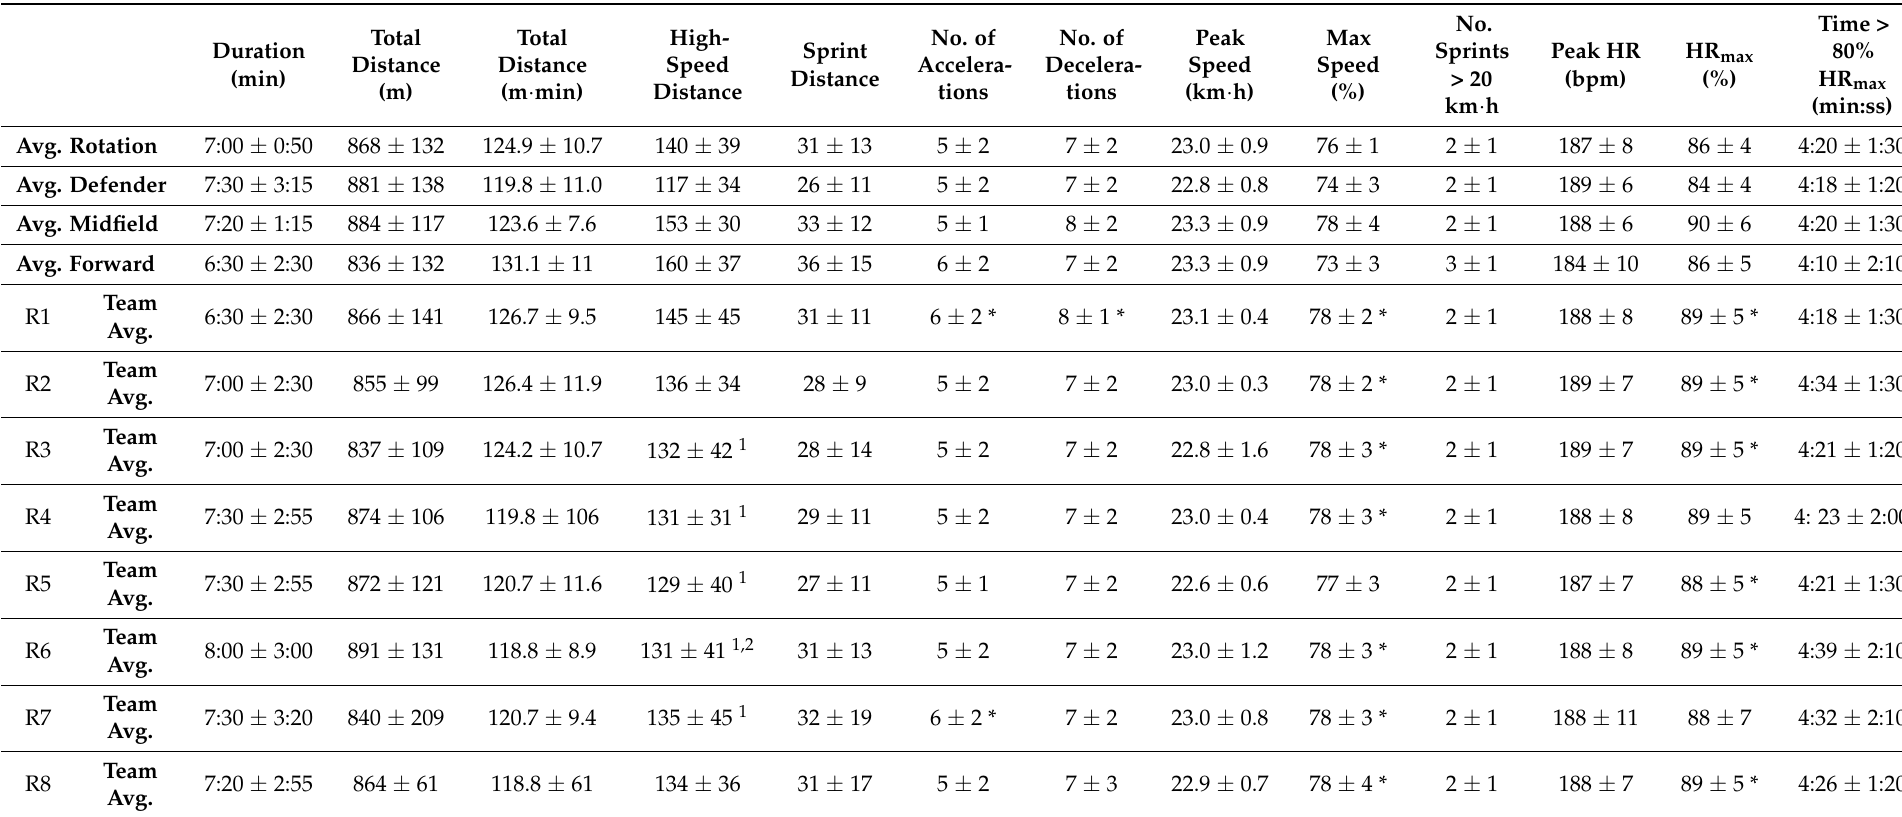
Table 1. The physical and physiological demands of elite international female field hockey across rotations, as determined by GPS technology during match-play. All data are presented as mean ± SD.